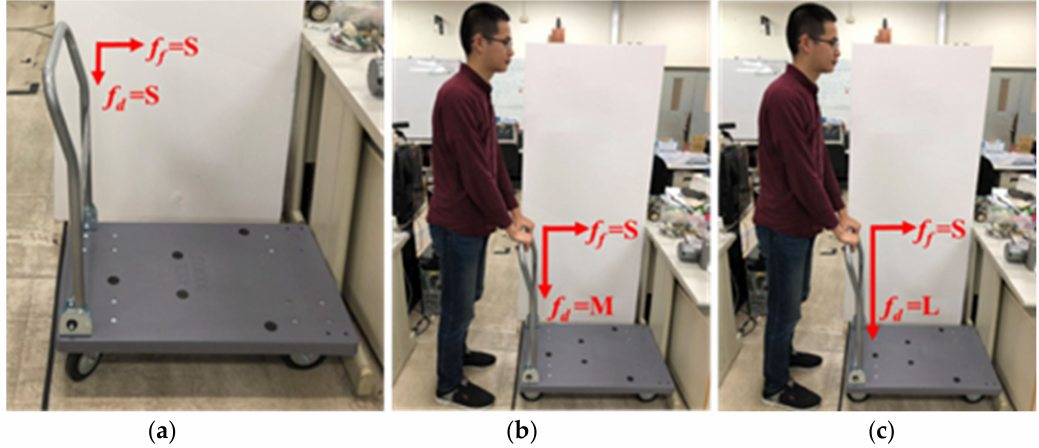
Figure 8. Posture judgment ( f f = S): ( a ) f d = S; ( b ) f d = M; ( c ) f d = L.